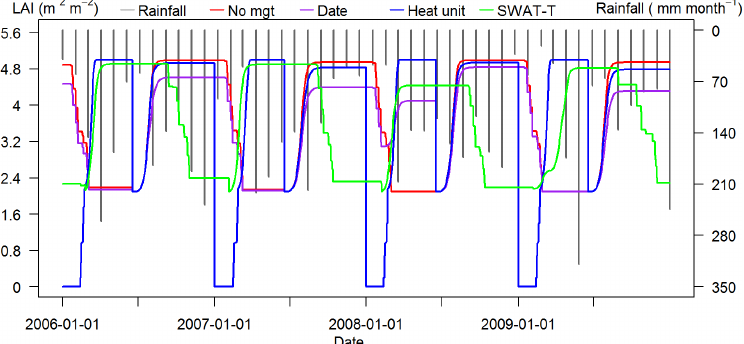
Figure 4. The daily LAI as simulated standard SWAT plant growth module with different management settings and by the modified plant growth module (SWAT-T) for evergreen forest (FRSE) using default SWAT parameters. The vertical lines (black) denote monthly rainfall (see management settings explanations in the text).